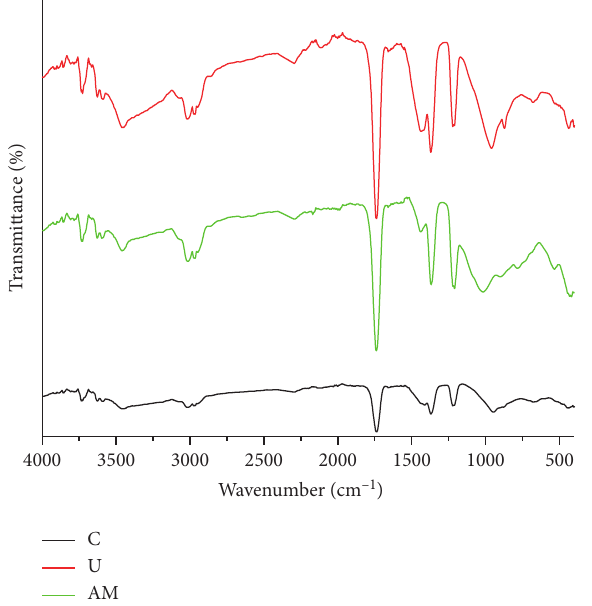
Figure 11: FT-IR image of 5M and 1: 2 of SH